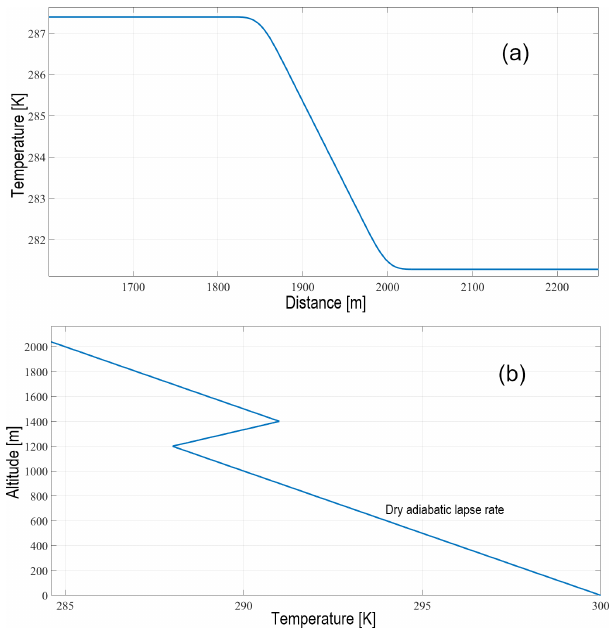
Figure 7. (a) Temperature change across a frontal inversion (cold front). (b) Vertical dry adiabatic lapse rate temperature profile with a strong thermal